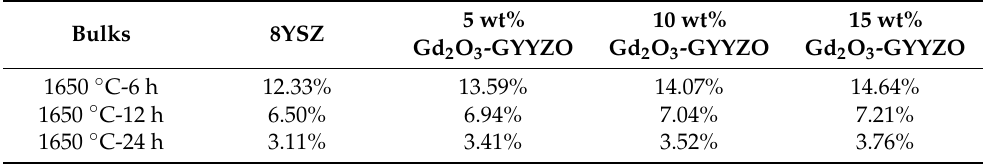
Table 3. The porosities of the sintered bulks through image processing.